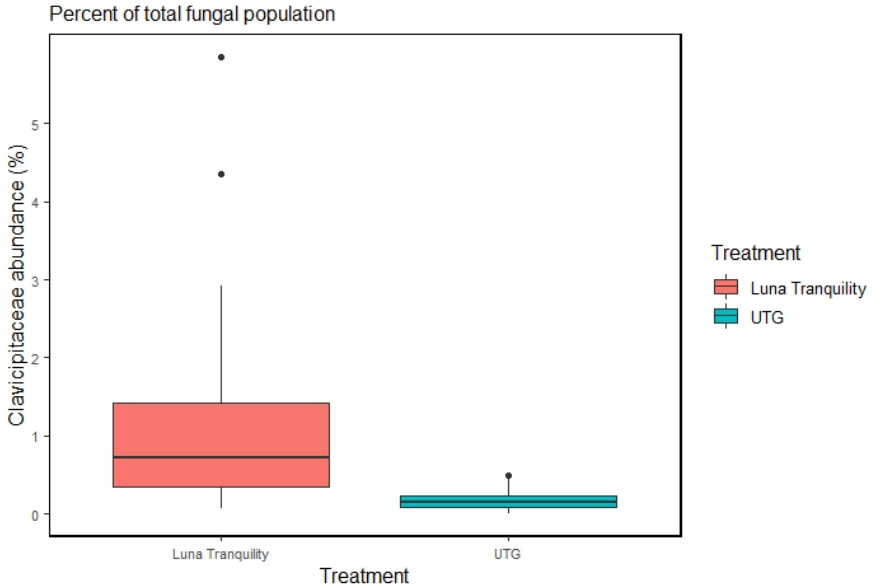
Figure 3. Clavicipitaceae abundances by treatment group. Abundances of Clavicipitaceae were significantly increased in plots treated with Luna Tranquility relative to UTG (Wilcoxon test, BH-corrected p value < 0.05).